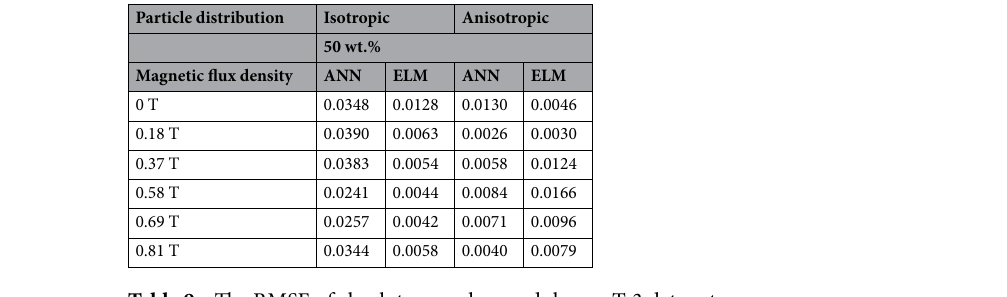
Table 9. The RMSE of absolute complex modulus on Ts3 data